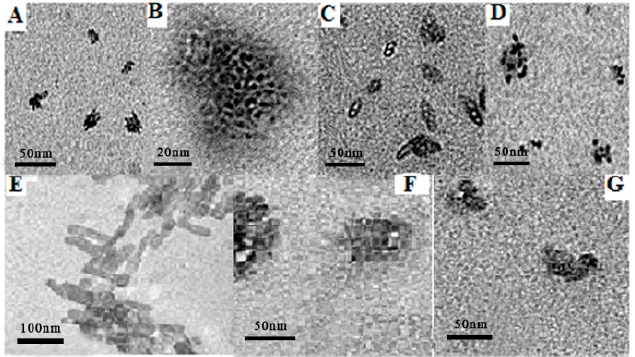
Figure 6. TEM images of ( A ) 1a ; ( B ) HR TEM image of 1a ; ( C ) 1a + NAP; ( D ) 1a + IBP; ( E ) 1b ; ( F ) 1b + NAP; ( G ) 1b + IBP.